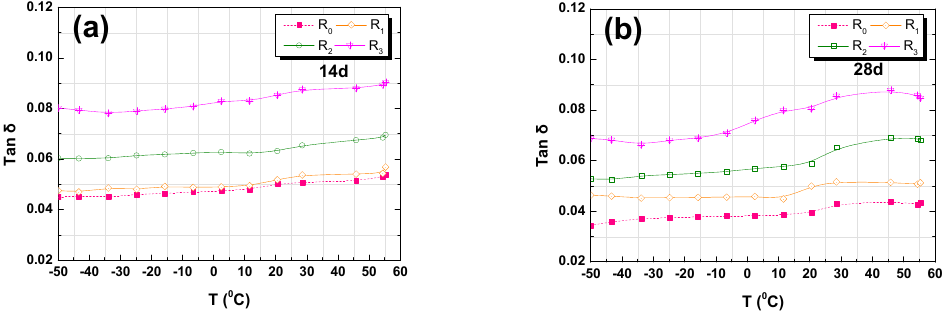
Figure 8. DMA analysis results of tan δ versus temperature: ( a ) 14-day; ( b ) 28-day.